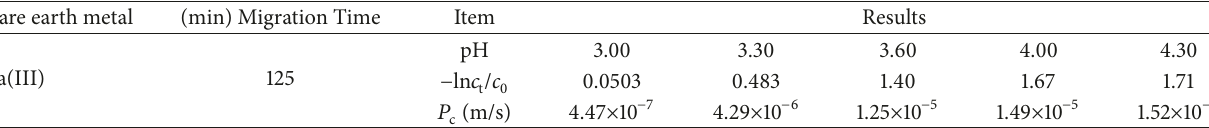
Table 1: Effect of pH in feed phase on transport of rare earths.